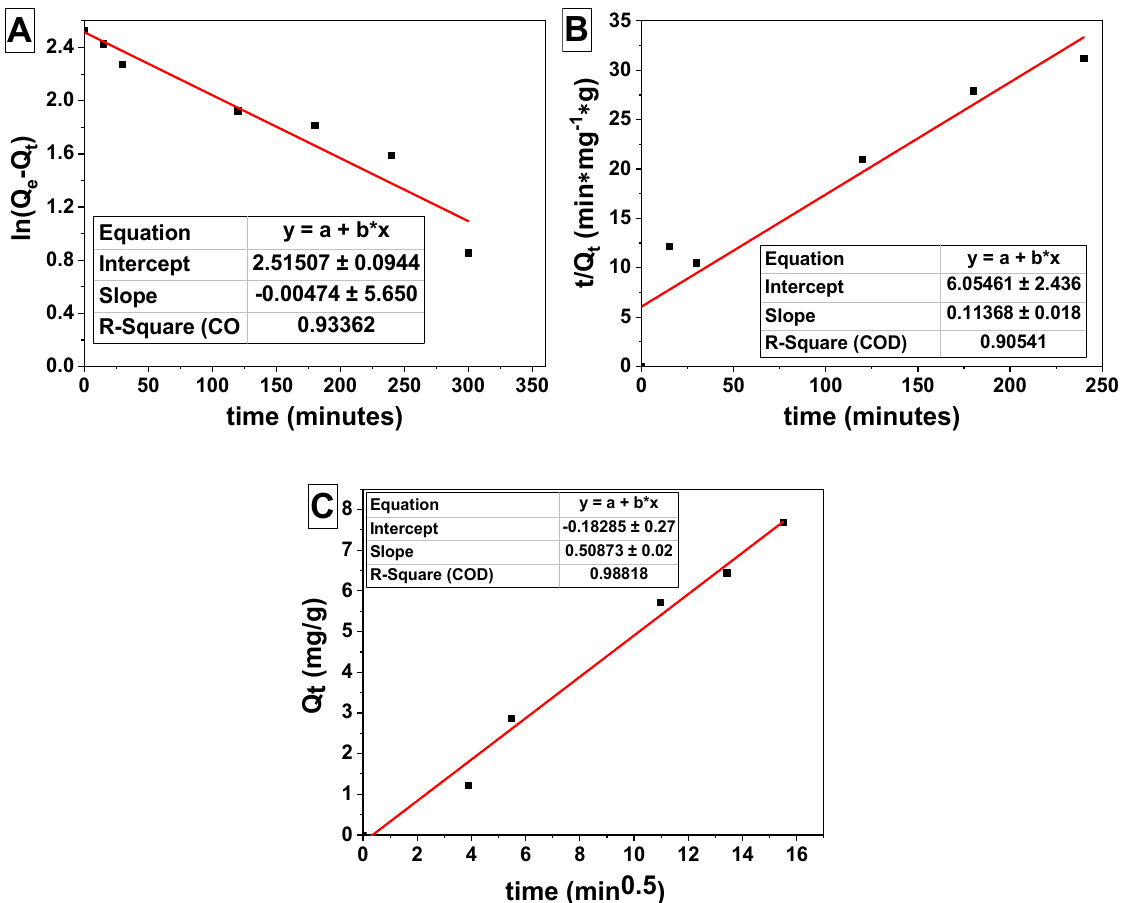
Figure 4. The linear plots of Lagergren’s pseudo-first-order ( A ), Ho’s pseudo-second-order ( B ), and Weber’s intraparticles diffusion models ( C ).